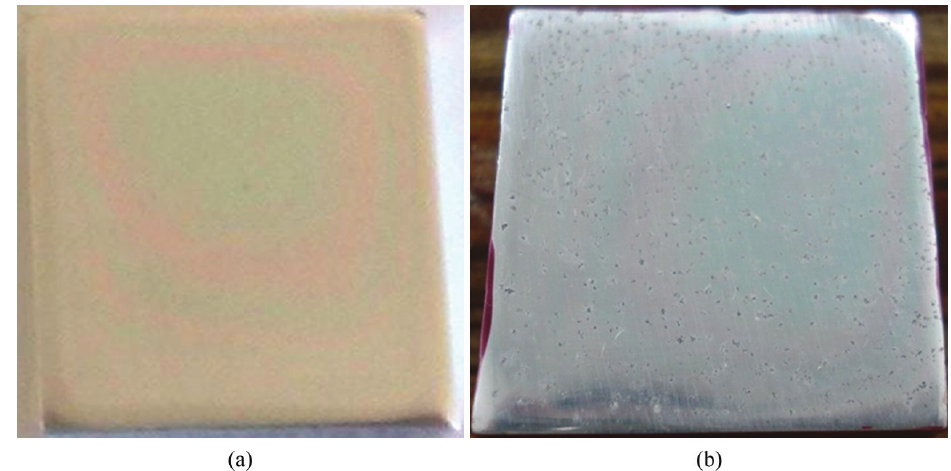
Figure 10. (a) Surface of the sample containing the film deposited in plasmas of 15 W of power, before the test and (b) after 145 h of exposure to salt spray.